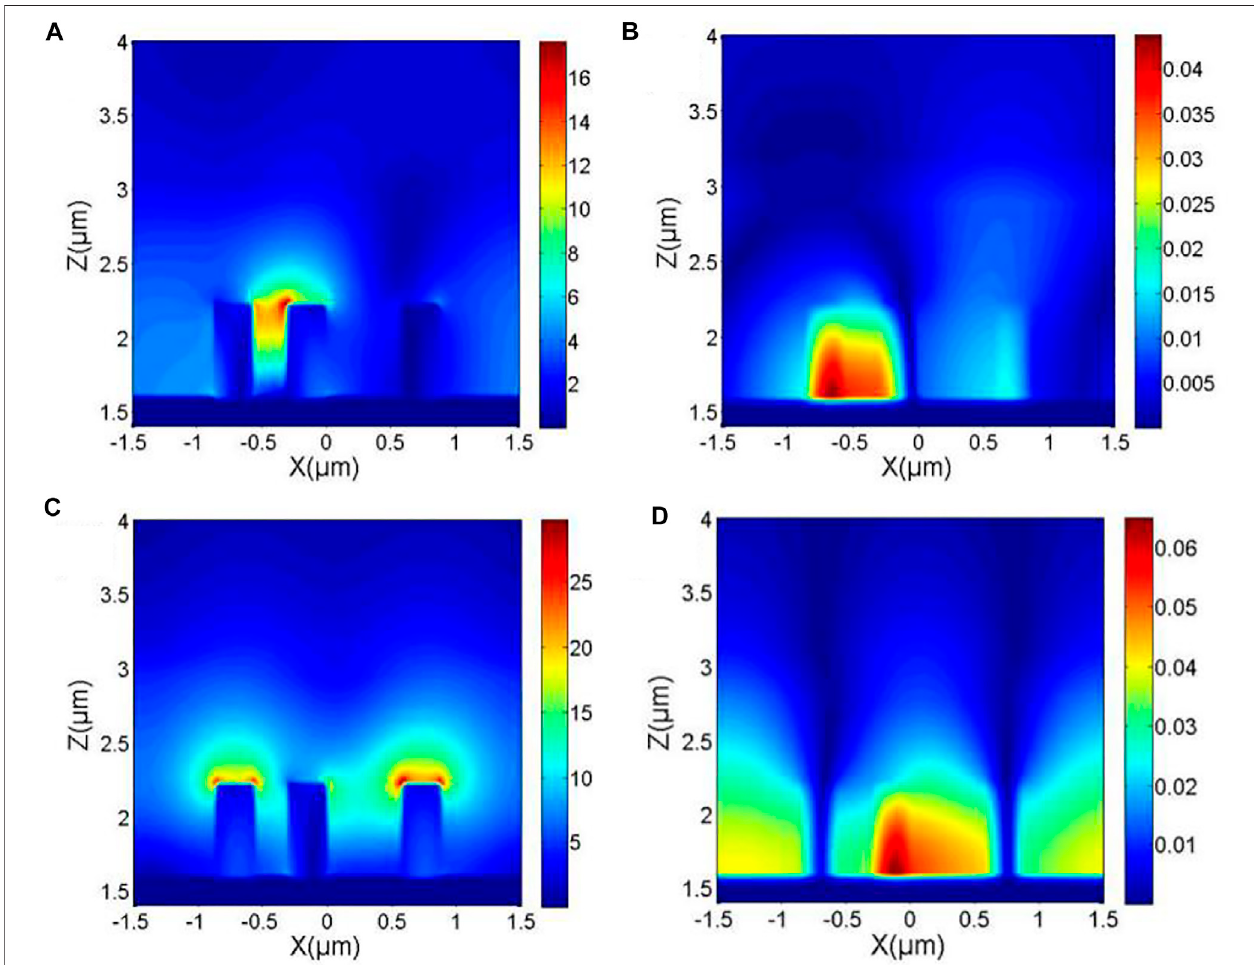
FIGURE 3 | (A) and (B) represent the electric and magnetic fi eld diagrams at λ 1 (cid:1) 3780 nm, respectively. (C) and (D) represent the electric and magnetic fi eld diagrams at λ 2 (cid:1) 4135 nm,